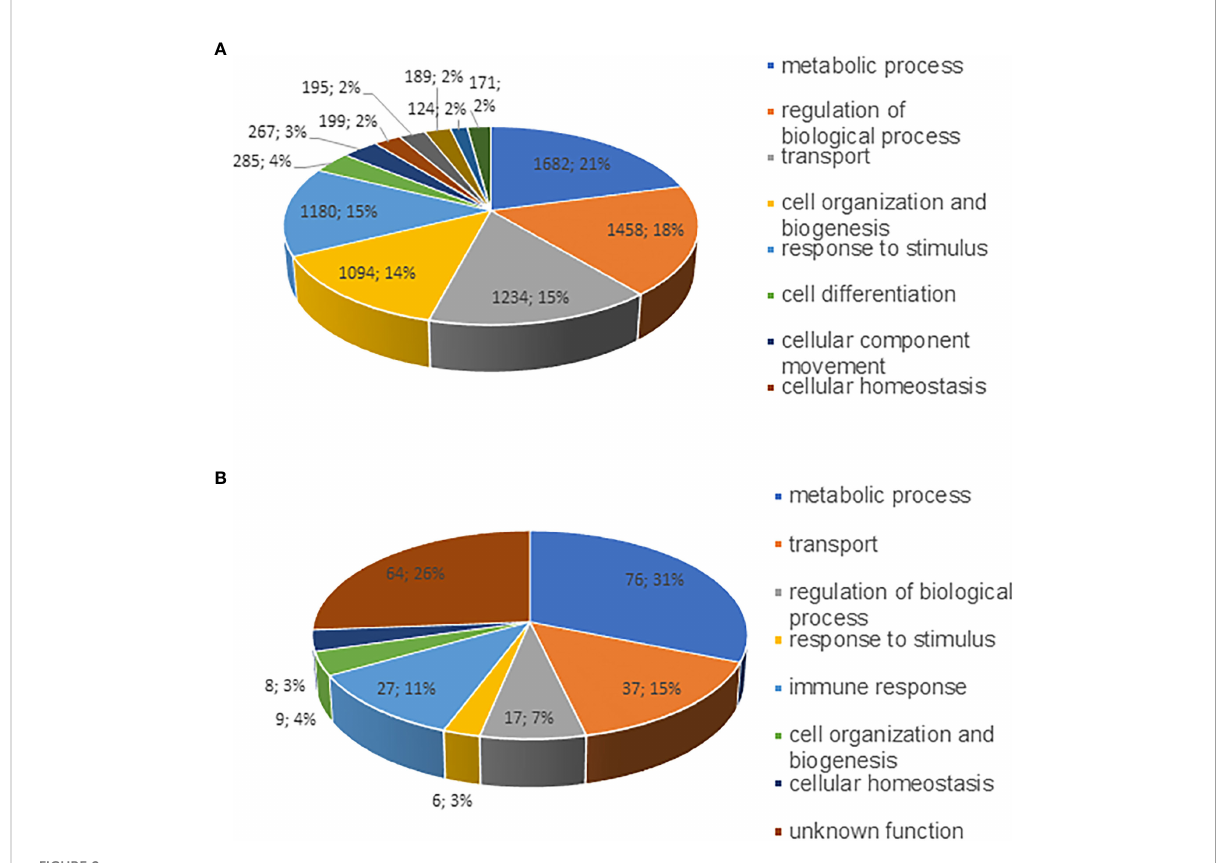
FIGURE 2 Pie charts representing proteins identi fi ed as various functional groups. Proteins identi fi ed from phagosome membranes were separated into as per their biological functional groups; (A) host membrane proteins and (B) E . chaffeensis proteins associated with the phagosome